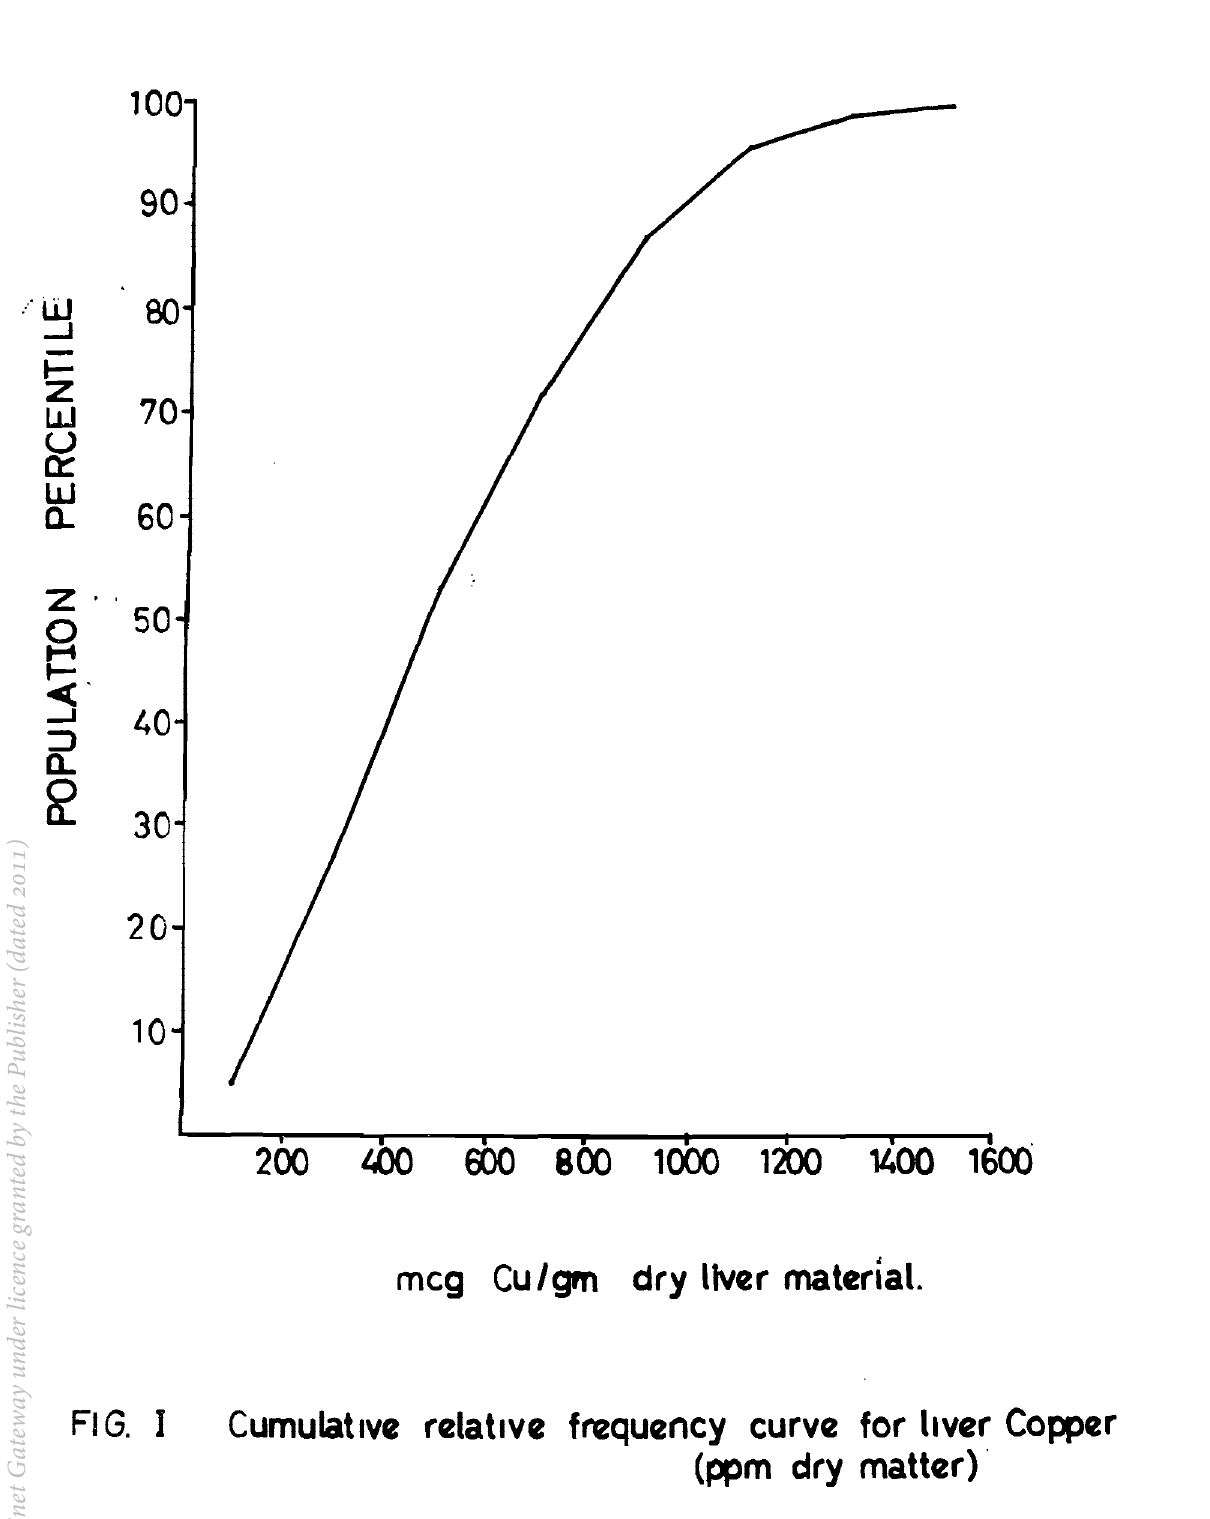
FI G. I Cumulative relative frequency curve for liver